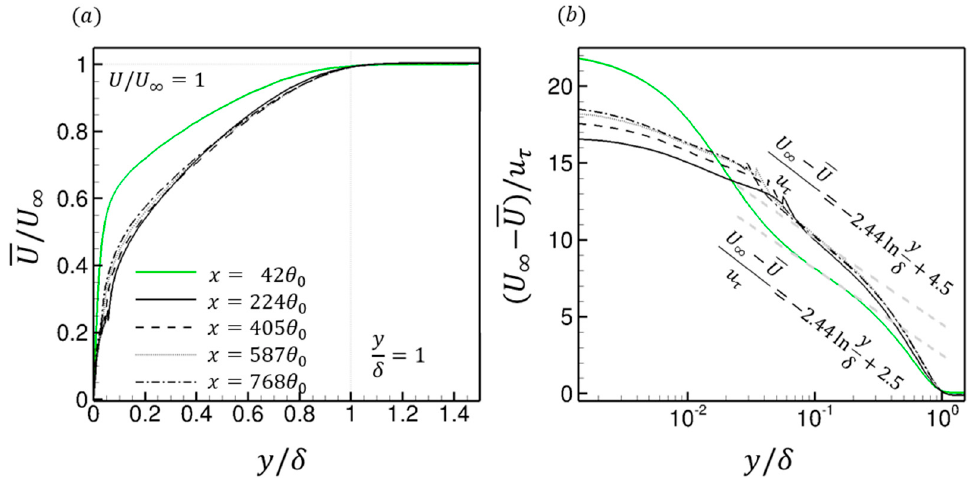
Figure 6. Mean velocity profiles at select streamwise fetch locations using ( a ) outer scaling and ( b ) defect-law scaling for the rough-wall case. The logarithmic equations in ( b ) correspond to the dashed gray lines. Upstream of the STR step change (green), downstream of the step change (black). Note that the results for reference and the rough-wall cases are identical upstream of the step change at x = 42 θ 0